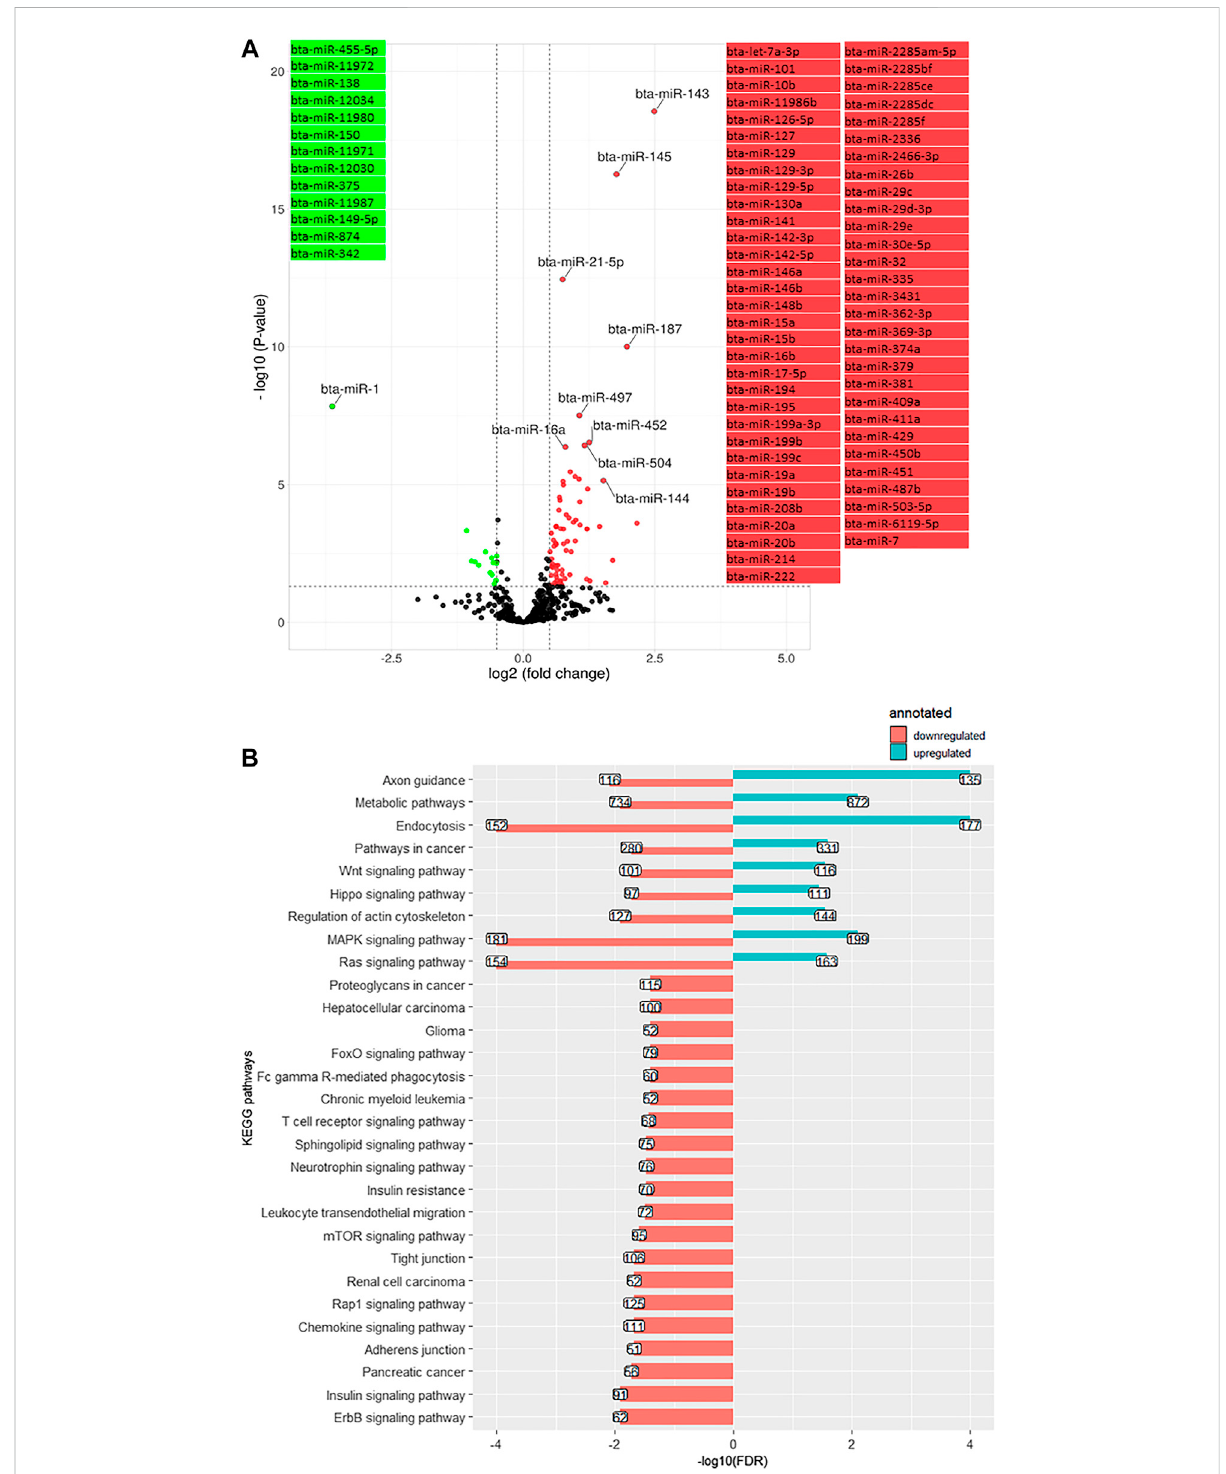
FIGURE 4 (A) . Volcano plot representing differentially expressed miRNA (DEM) between day -21 and +1 relative to parturition (day +1/-21); increased (red dots) and decreased (green dots) miRNA in d+1/d-21 are highlighted ( p < 0.05 and log2 fold change (FC) > 1.3). (B) . KEGG pathways annotated to DEM; Bars indicate proportional to the false discovery rate (FDR) adjusted p -value, and the box on each bar represents the gene counts